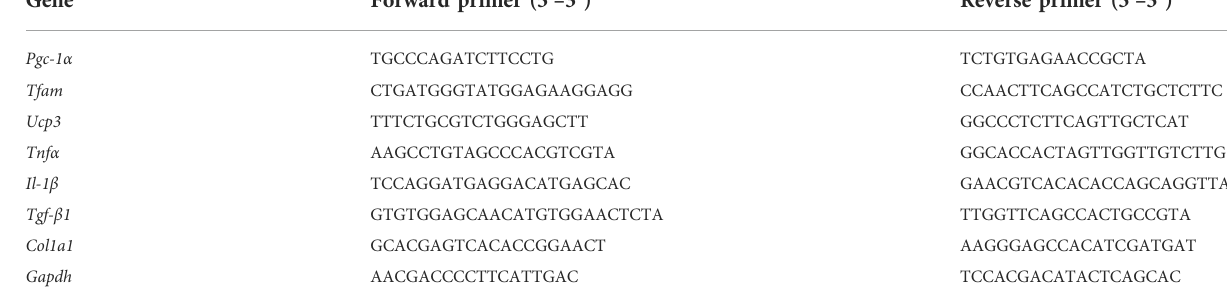
TABLE 2 Primers used for real-time quantitative